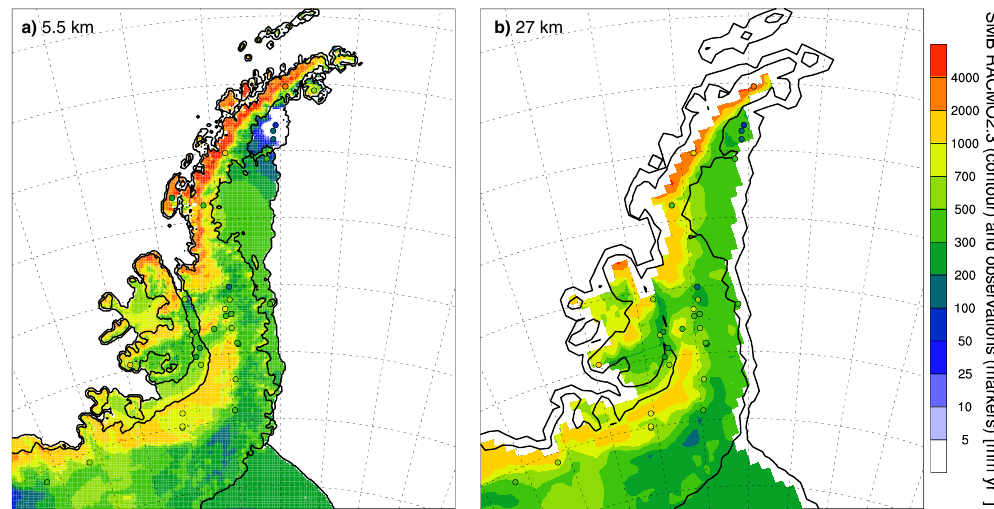
Figure 6. Modelled SMB (colours) and observations (markers) in mmweyr − 1 at 5.5km ( a ) and 27km ( b ) horizontal resolution (Van Wessem et al., 2014b). Observations are from Turner et al. (2002), Favier et al. (2013) and Scambos et al. (2014) and sources noted in Sect. 2.3, and only shown if they represent a period > 5 years. Modelled SMB is the 1979–2014 climatological average. At both resolutions only ice sheet grid points are shown.